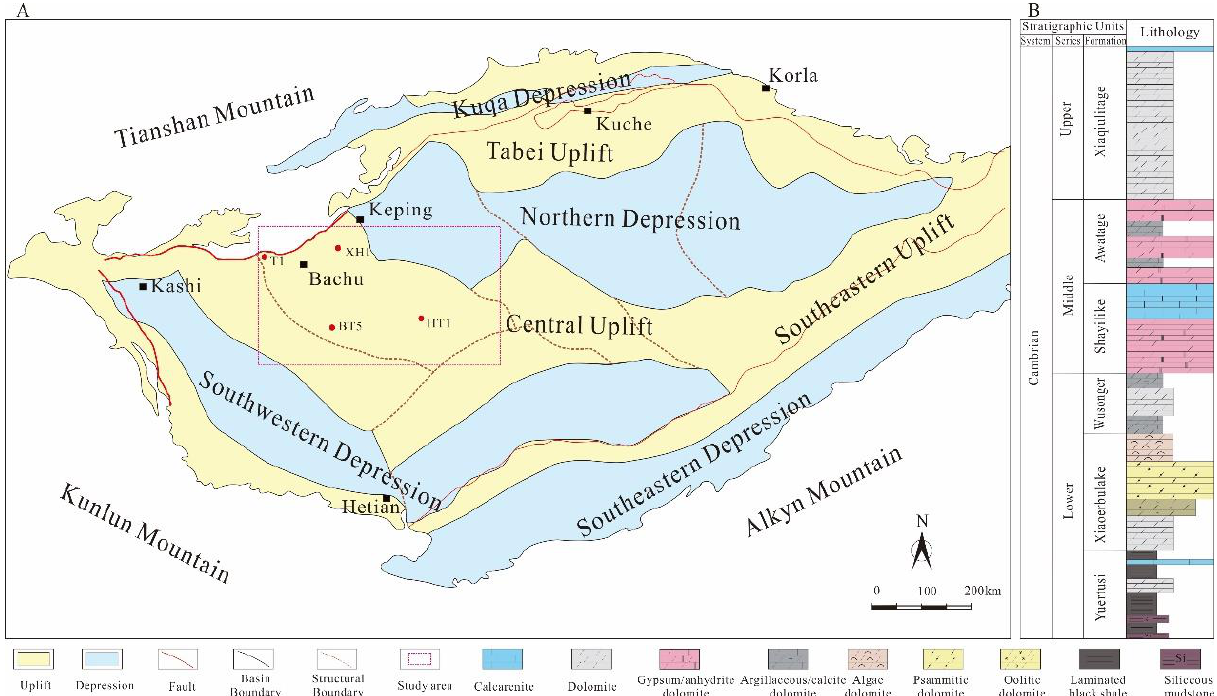
Figure 1. ( A ) Sketch map showing the geotectonic components of the Tarim Basin (modified from Du et al. (2017) [28]); ( B ) generalized diagram showing the stratigraphy and lithofacies of the Cambrian successions in the Bachu area (modified from Hu et al. (2019) [22]).